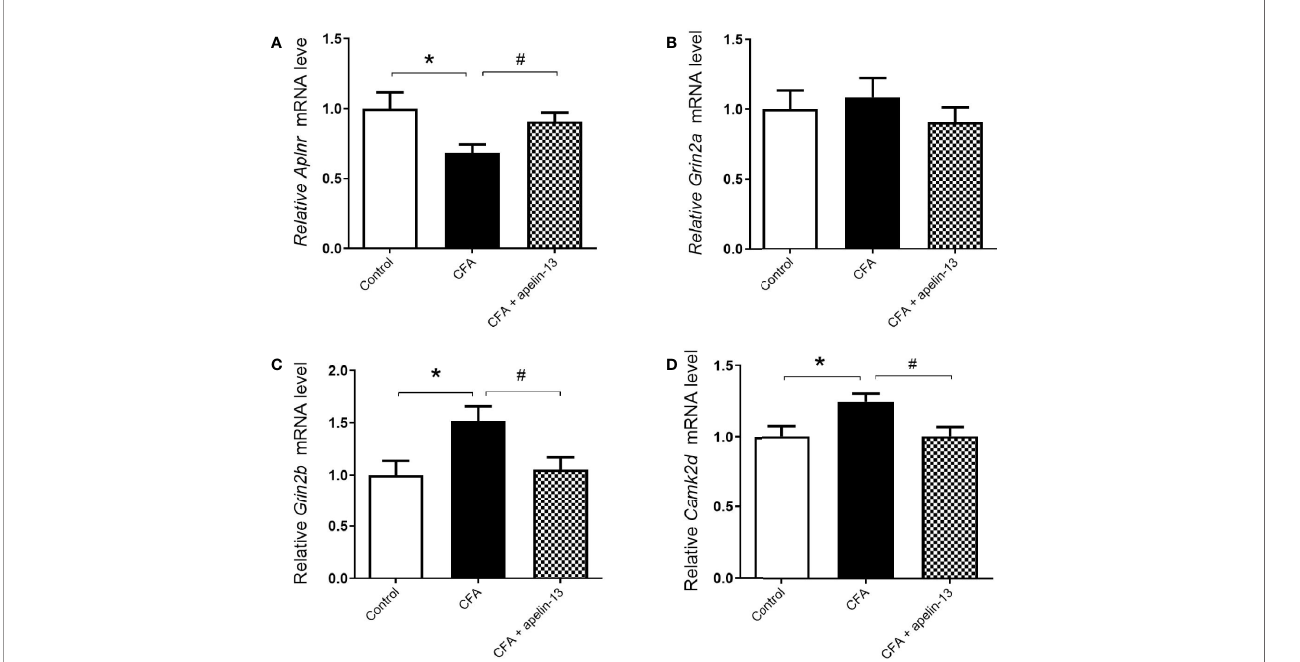
FIGURE 3 | Effect of i.t. apelin-13 on gene expression in the L4/5 spinal cord of mice. mRNA expression levels of Aplnr (A) , Grin2a (B) , Grin2b (C) and CamK2d (D) were normalized with the housekeeping gene 36B4 mRNA expression using real-time qPCR. Data are expressed as means ± SEM. n = 6 – 9 per group. * p < 0.05, compared with vehicle control (i.d. NS + i.t. NS); # p < 0.05, compared with CFA group (i.d. CFA + i.t. NS).